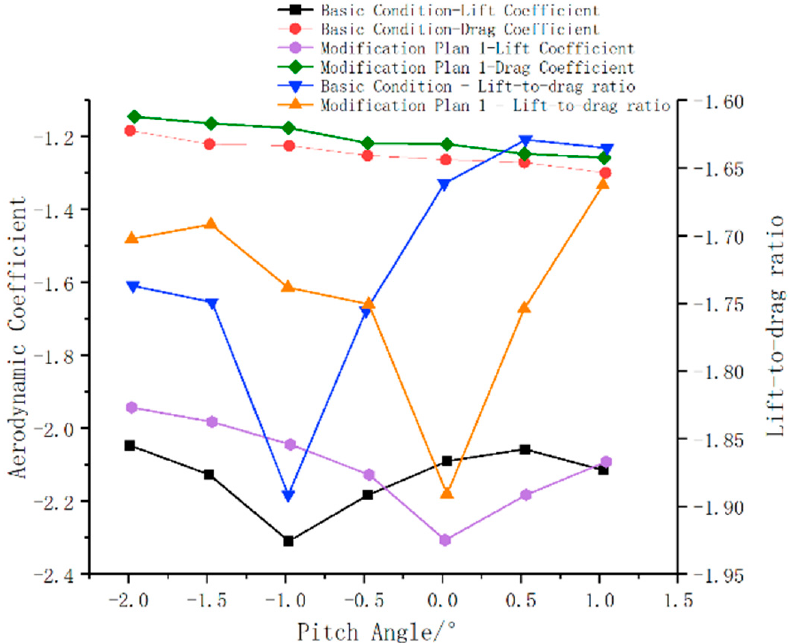
Figure 20. Curves of lift coefficient, drag coefficient and lift-to-drag ratio after adjusting aerodynamic